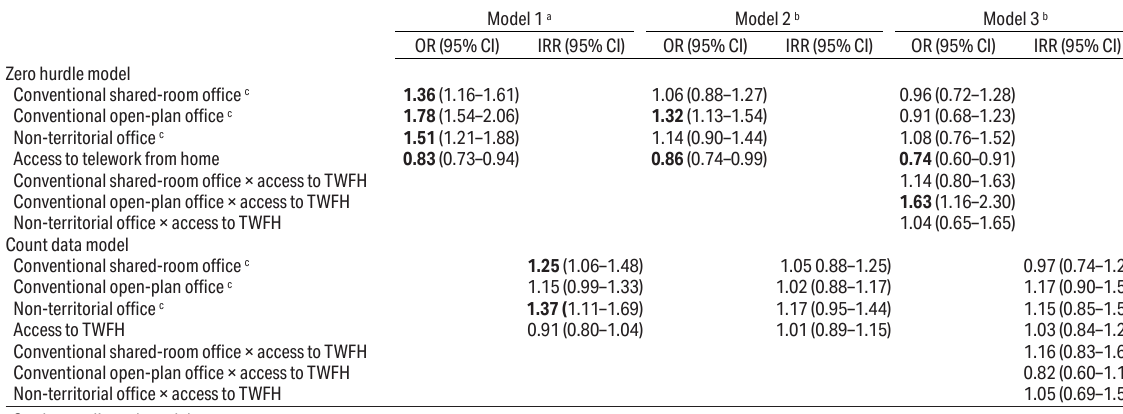
Table 3. Effects of office design and access to telework from home on self-certified sickness absence. [OR=odd ratio; CI=confidence interval; IRR=incidence rate ratio; TWFH=telework from home.] Statistically significant coefficients in bold .